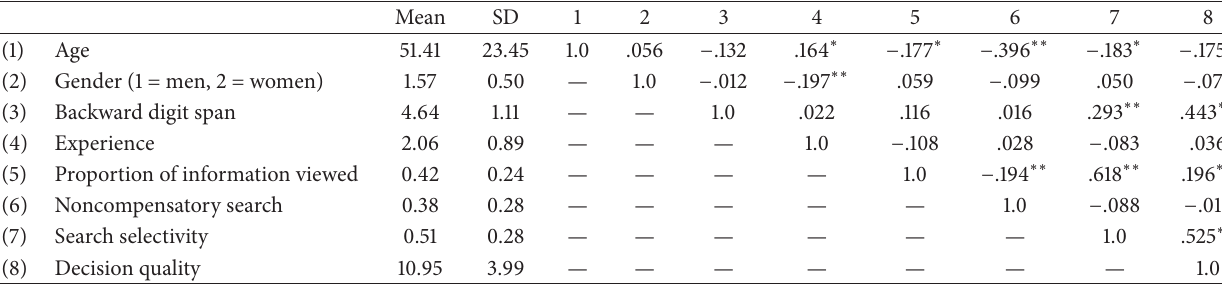
Table 1: Descriptive statistics and